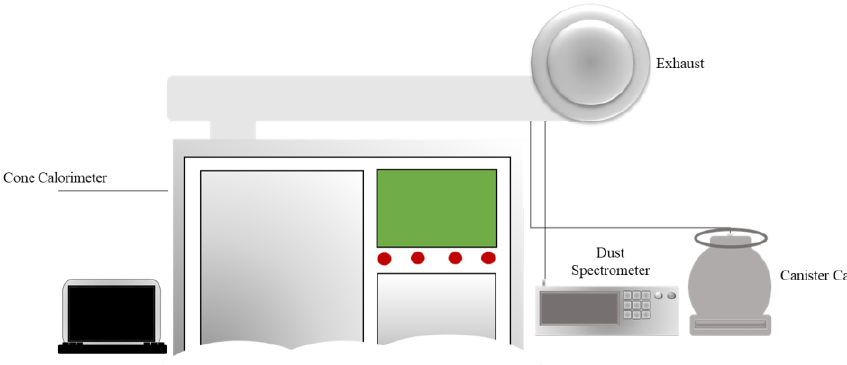
Figure 1. Schematic diagram showing the experimental set-up of the dual-cone calorimeter.